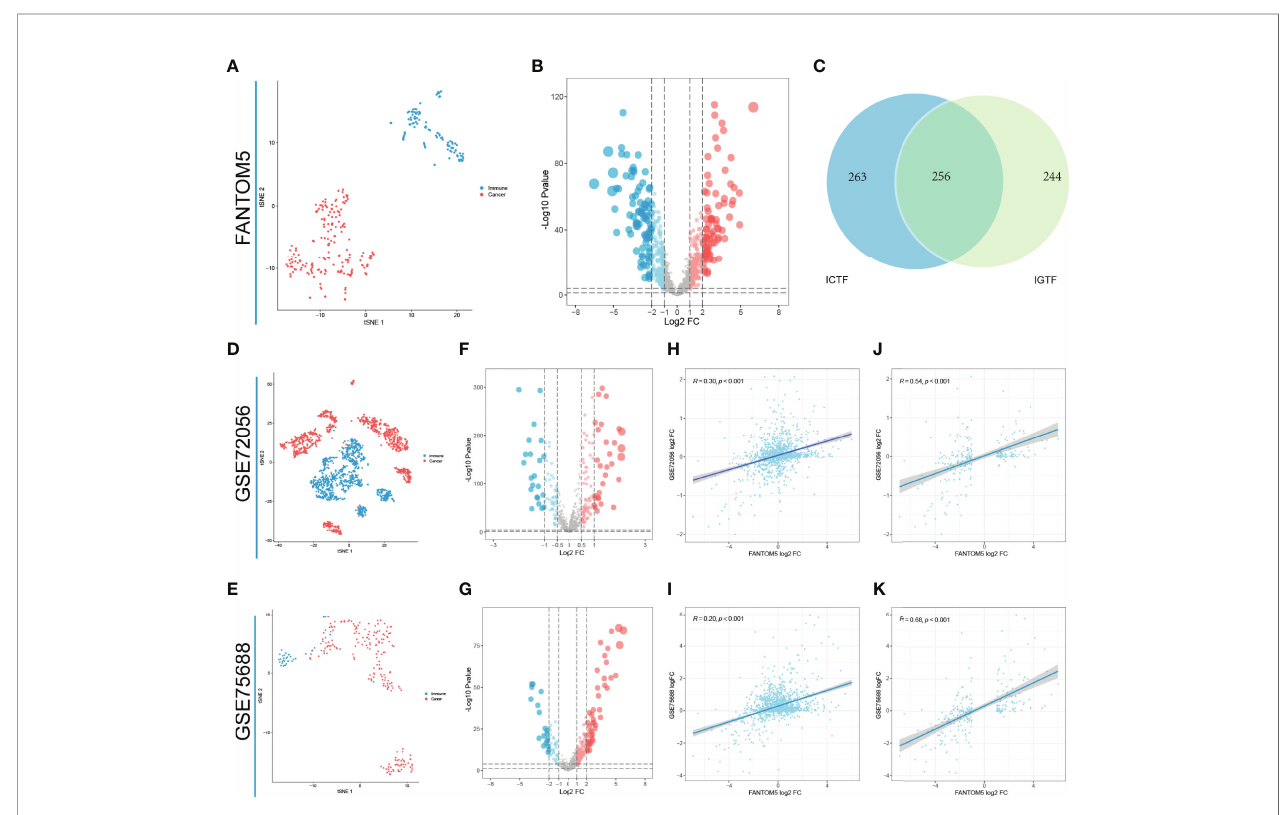
FIGURE 1 | Identi fi cation of IRTFs. (A) The t-SNE result of classifying 110 immune cells and 194 solid cancer cell lines from FANTOM5. (B) The differential expression analysis between 110 immune cells and 194 cancer cell lines from FANTOM5. (C) Identi fi cation of 256 IRTFs. (D, E) The t-SNE results of classifying immune cells and 194 tumor cells from GSE72056 and GSE75688. (F, G) The differential expression analysis between immune cells and tumor cells from GSE72056 and GSE75688. (H, I) Expression patterns of TFs in GSE72056 (R = 0.30) and GSE75688 (R = 0.20) were signi fi cantly correlated with those in FANTOM5. (J, K) Expression patterns of IRTFs in GSE72056 (R = 0.54) and GSE75688 (R = 0.68) were more correlated with those in